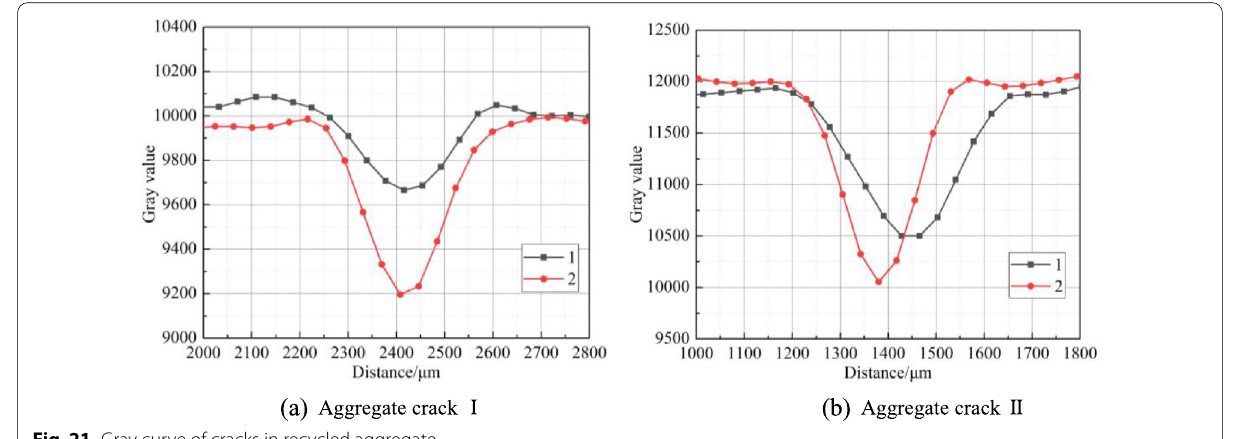
Fig. 21 Gray curve of cracks in recycled